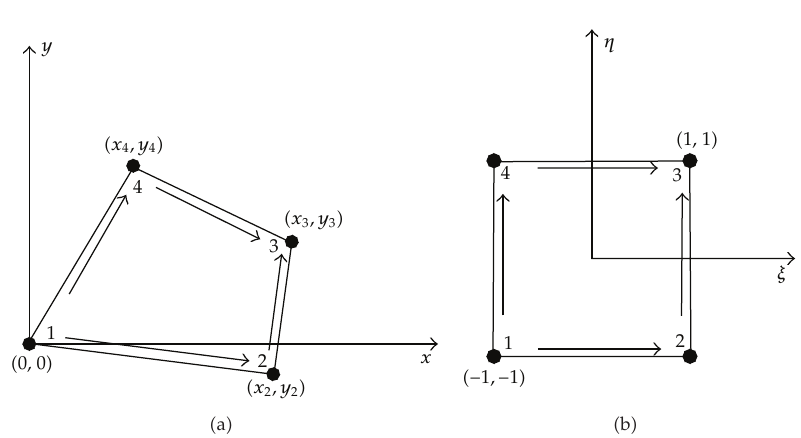
Figure 2: The coordinate transformation of a quadrilateral